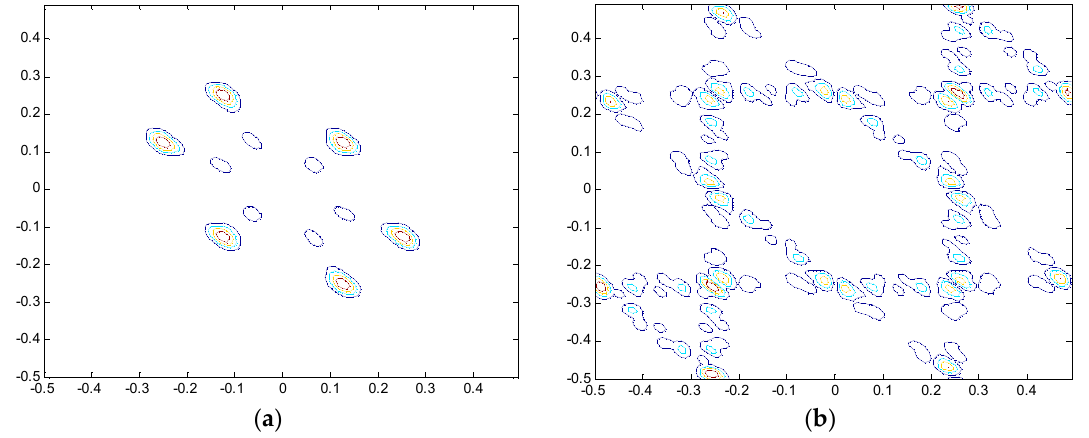
Figure 1. Simulation results of bi-spectrum under variable working conditions: ( a ) bi-spectrum analysis of signal x 1 ; and ( b ) bi-spectrum analysis of signal x 2 .